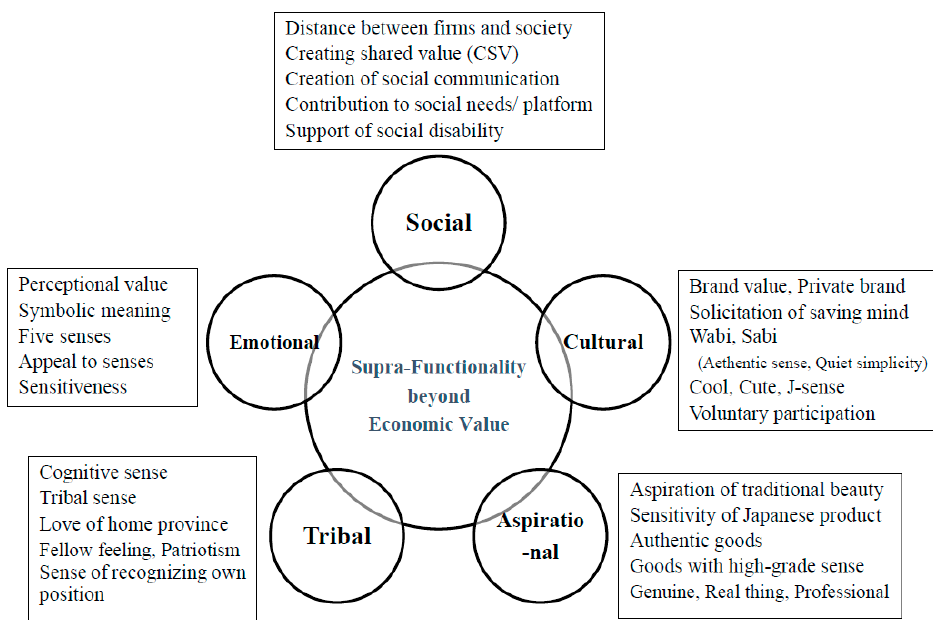
Figure 3. Concept of supra-functionality beyond economic value. Sources: [7–9].